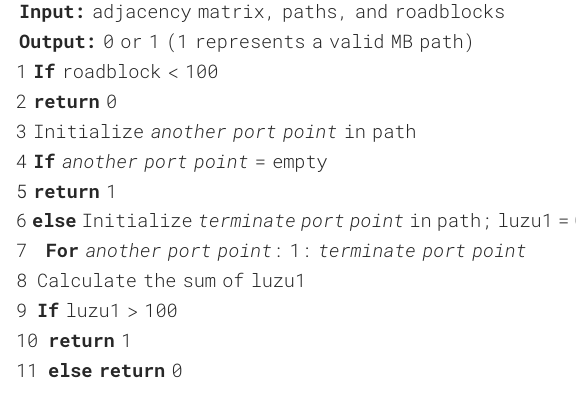
Algorithm 3: MB judgment in the load current